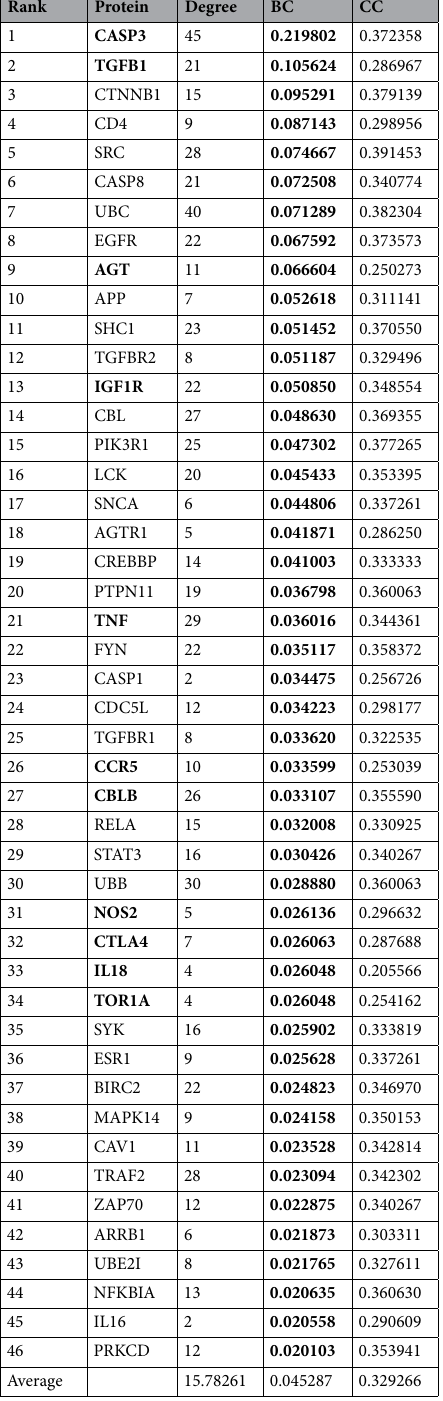
Table 2. The list of nodes with top 20% BC and their DC and CC values. The bold proteins were also seed proteins. There were 11 seed